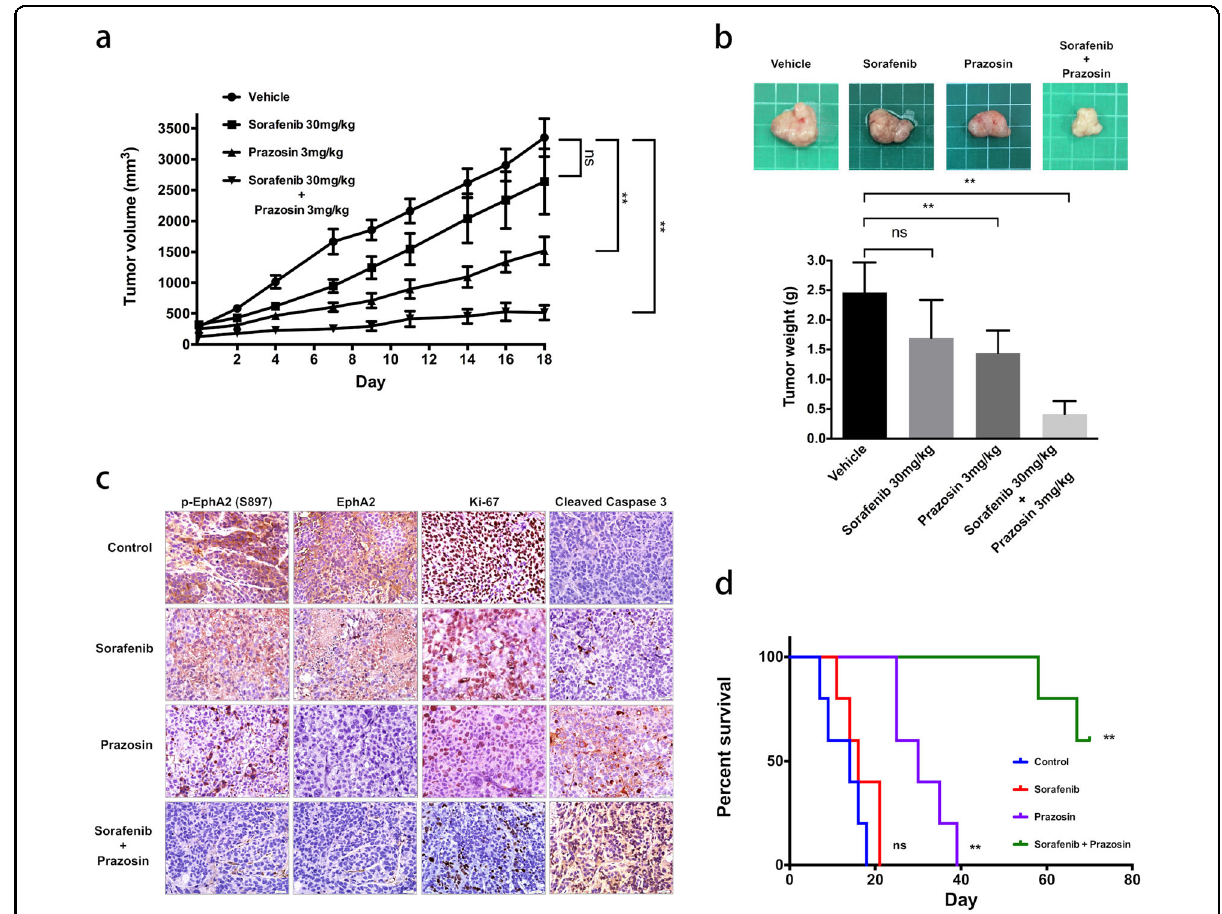
Fig. 7 Prazosin overcomes sorafenib resistance in vivo. HuH-7 R cells were subcutaneously injected into nude mice. At a tumor volume of ~200 cm 3 , mice were orally treated with vehicle ( N = 5), sorafenib at 30 mg/kg ( N = 5), and/or prazosin at 3 mg/kg ( N = 5) for 18 days. a Measurement of tumor volumes. b Upper, representative images of tumor xenografts. Lower, tumor weights after the end point. c Tumor sections were analyzed via immunohistochemistry. Paraf fi n-embedded sections of tumor tissue were stained with the indicated antibodies. Representative sections at ×400 magni fi cation. d Survival times were calculated with the Kaplan – Meier method. Statistical data were calculated from fi ve replicates under a single independent experimental design (ns not signi fi cant; ** p <